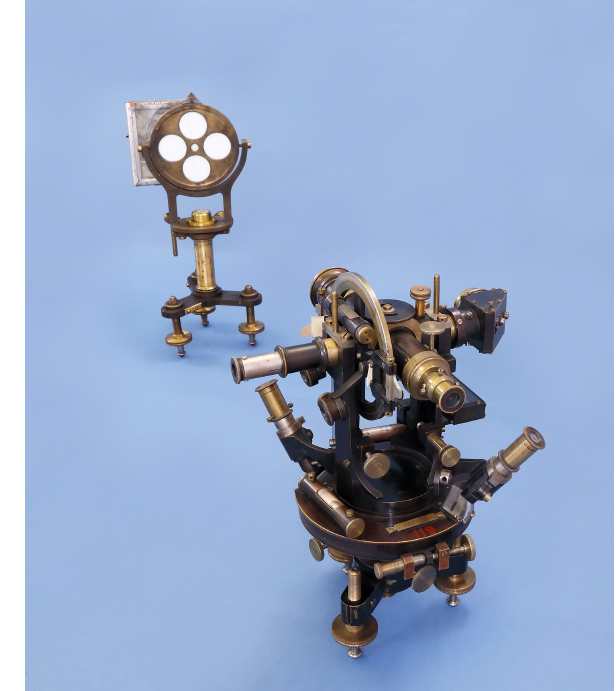
Figure 4. Theodolite DUPLEX by J. & J. Friˇc company (photo supplied by https://www.surveyinginstruments.org).